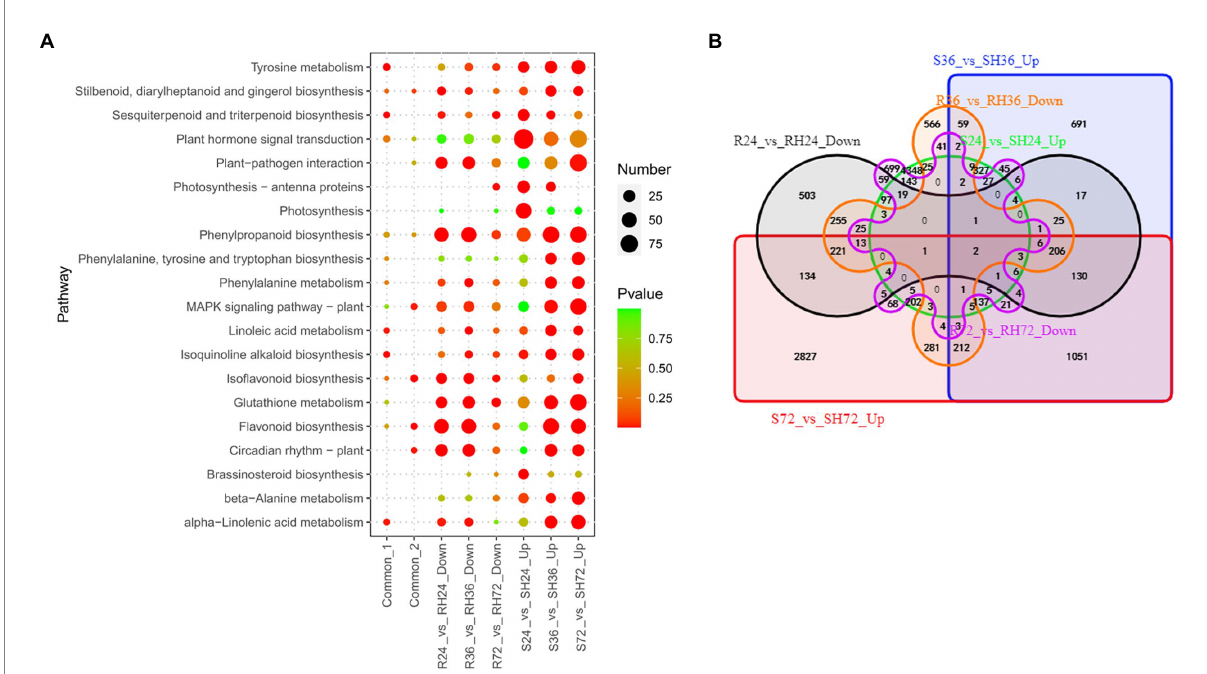
FIGURE 8 Identification of T3Es induced susceptibility-response DEGs in R24 vs. RH24, R36 vs. RH36, R72 vs. RH72, S24 vs. SH24, S36 vs. SH36, and S72 vs. SH72. (A) KEGG enrichment analysis of common, up-regulated, and down-regulated DEGs in each treatment comparison. Common-1 indicates the common up-regulated DEGs in S24 vs. SH24, S36 vs. SH36, and S72 vs. SH72. Common-2 is the common down-regulated DEGs in R24 vs. RH24, R36 vs. RH36, and R72 vs. RH72. (B) A big Venn diagram of DEGs for up-regulated DEGs in Ss vs. SHs and down-regulated DEGs in Rs vs.